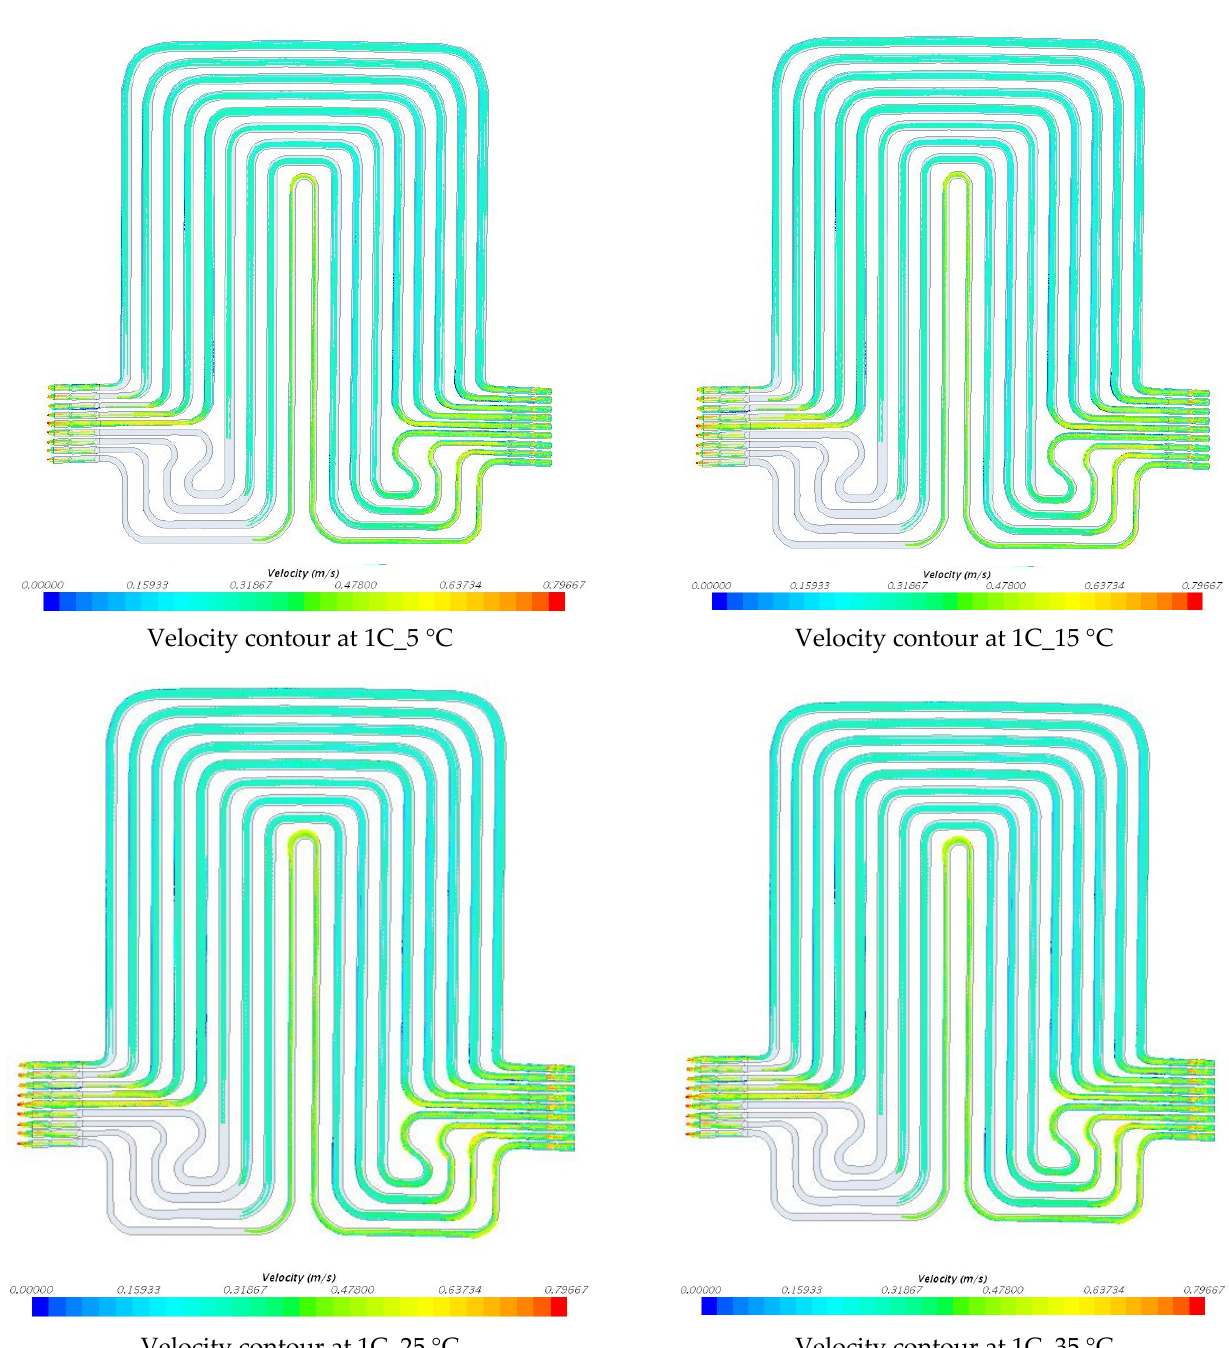
Figure 15. Velocity distribution at 20 A discharge current and 5 °C, 15 °C, 25 °C, and 35 °C coolant inlet temperature.